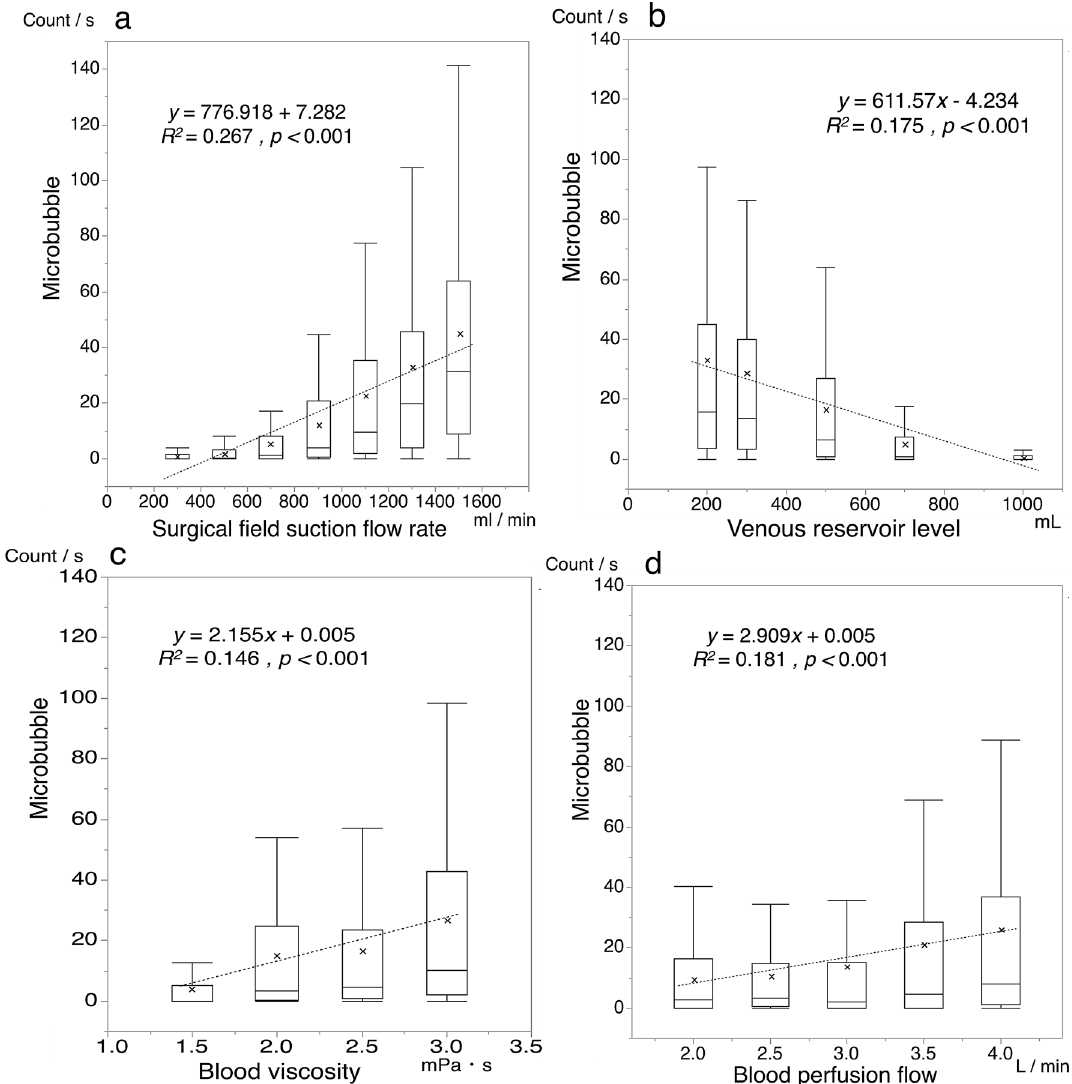
Figure 1. Correlation between each factor and the number of microbubbles. Dotted lines denote linear regression approximations. Plots ( a – d ), show the numbers of microbubbles as functions of the suction flow rate, venous reservoir level, blood viscosity, and perfusion flow rate, respectively. Cross marks denotes the average decreases. The MBs thus immediately reach the reservoir outlet and flow out, then increasing their numbers. Therefore, a negative correlation was observed. In the case of the surgical field suction flow rate ( SFR ), the number